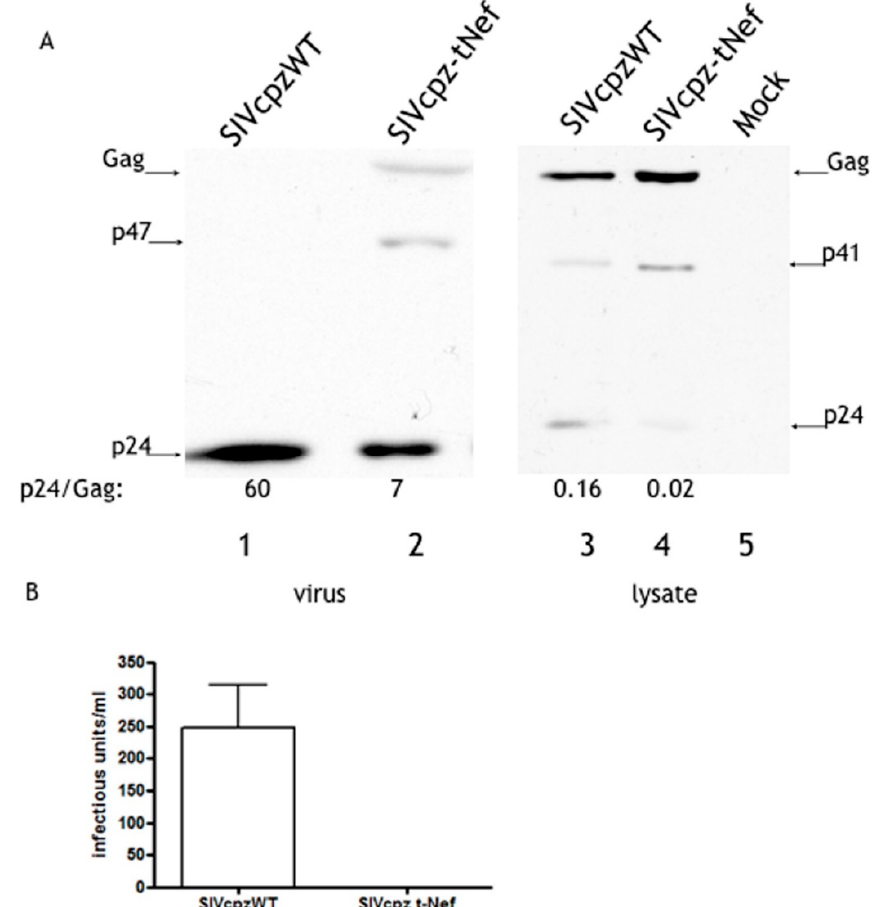
Figure 2. The SIVcpz-tNef phenotype is reproducible in Molt cells. ( A ) Concentrated cell-free of Molt cells transiently transfected with SIVcpzWT and SIVcpz-tNef were processed for Western blot with polyclonal α -CA; ( B ) the infectivity of normalized viral stocks was measured by the TZM-bl assay. Error bars are the standard deviation of the mean. The results are representative of four independent experiments.